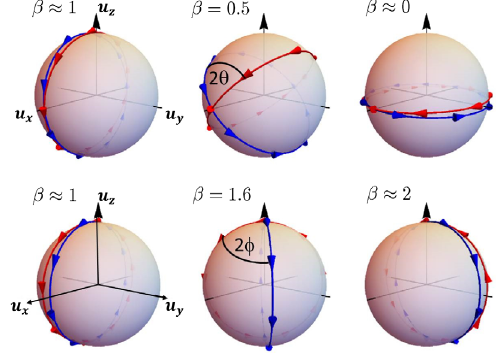
FIG. 7. Evolution of the winding plane around the tilted Dirac cones. The arrows indicate the direction of h ð q Þ as a function of β around the two Dirac cones (red and blue lines, respectively) emerging from the parabolic-flat-band